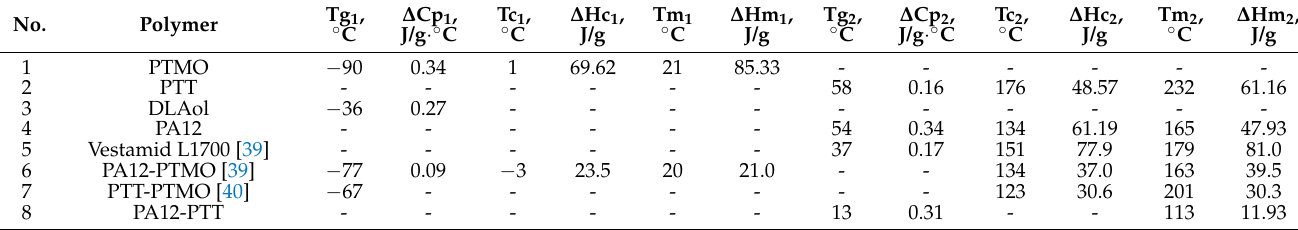
Table 5. Thermal properties of homopolymers and